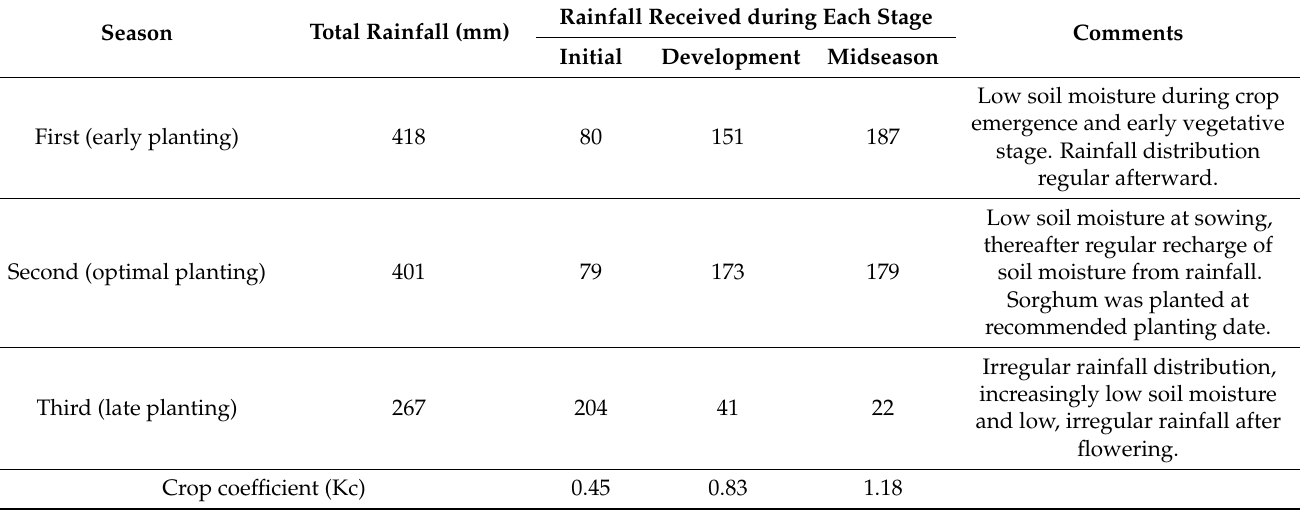
Table 1. Rainfall received at three key developmental stages when planted in three planting seasons (at three planting dates).